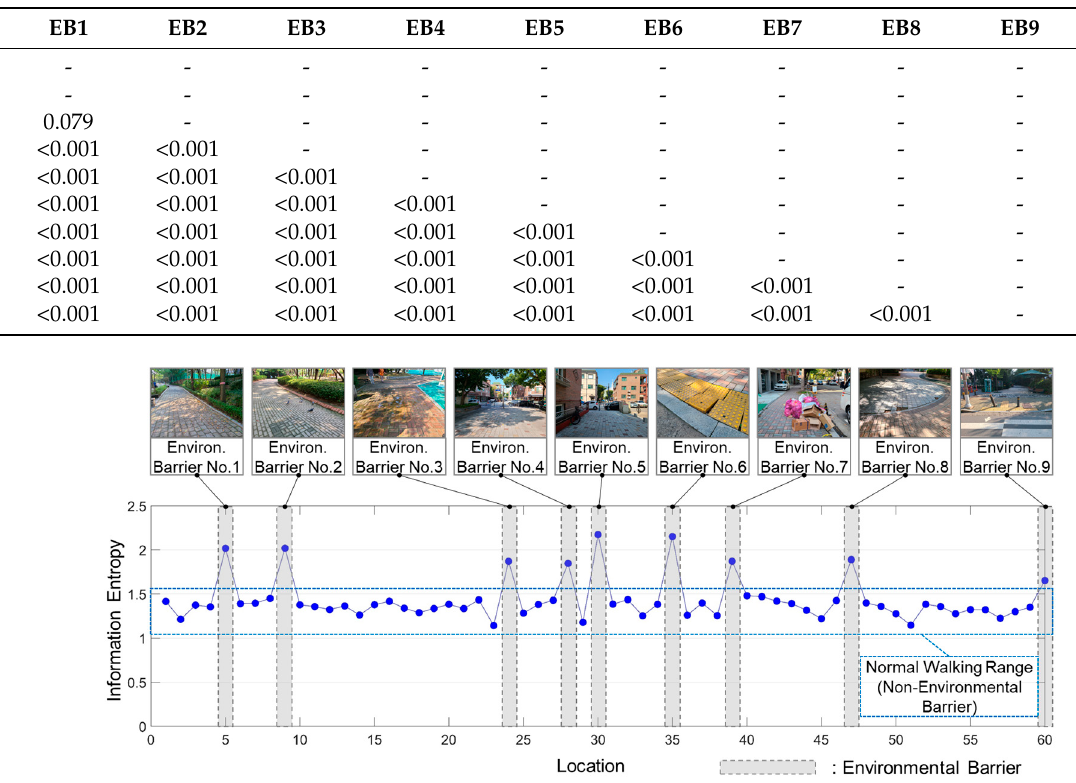
Figure 6. Information entropy value by location.